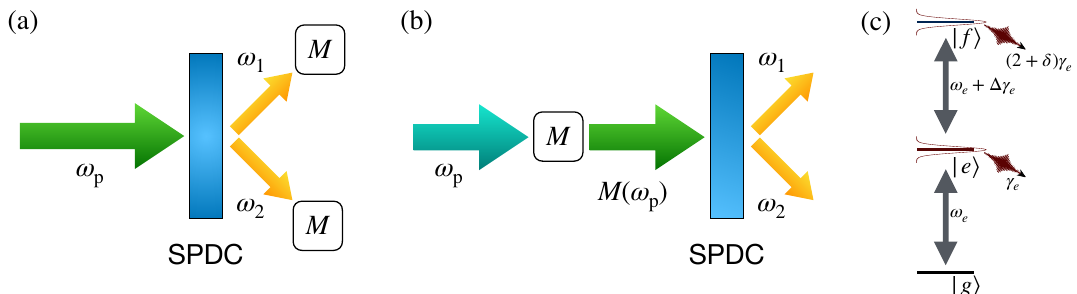
Figure 4: Exemplary experimental scenarios discussed in (a) Sec. 4.3 and (b) Sec. 4.4. In (a) two photons of frequencies ω parametric down-conversion (SPDC) from a pump photon of frequency ω photons are then frequency-modulated by the same pulse shaping operator M . In (b), instead, it is the pump photon that is shaped by an optimal operator M , before describing the matter degrees of freedom as in Fig.